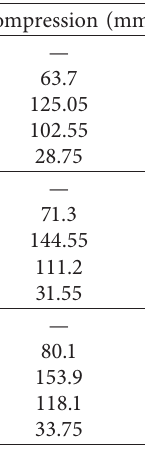
Figure 9: Layered settlements at different depths. Table 3: Layered settlements and